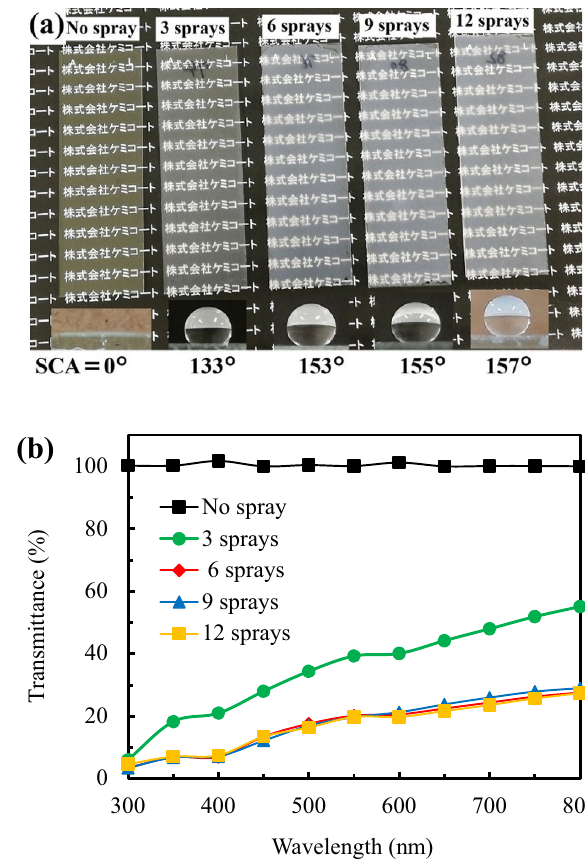
Fig. 4 Optical photographs of ( a ) the coating solutions prepared by the processing method II with the addition of ammonia and nitric acid as a catalyst of the hydrolysis and condensation of TEOS and DDTMS, and ( b ) the coatings formed on the glass slides by slid- ing of syringe of 0.5 ml coating solutions (Left: black background only, Right: black background with white Japanese characters). The lower images of Fig ( b ) were optical photographs of two 10 μL water droplets on the coating surface showing the water repel- lency